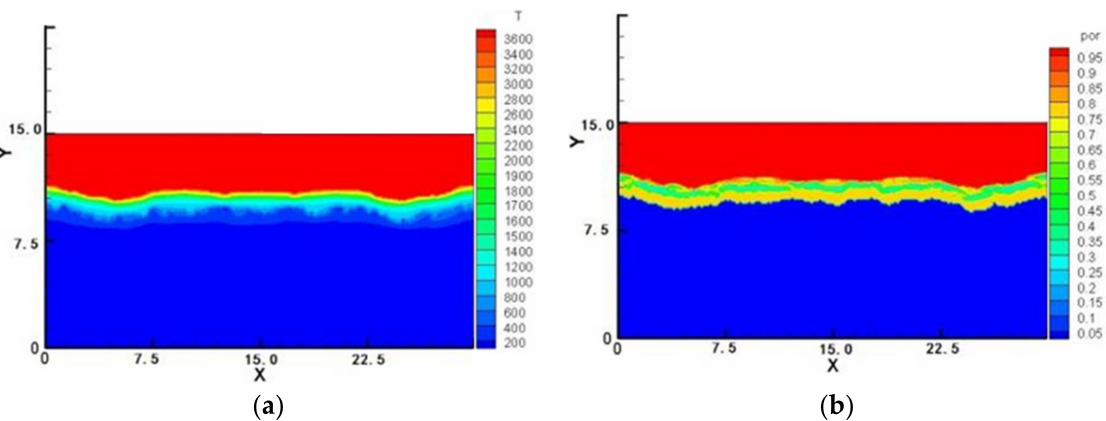
Figure 17. Numerical calculation results under the gas phase velocity of 2 m/s: ( a ) the temperature (°C) distribution contour; ( b ) porosity distribution